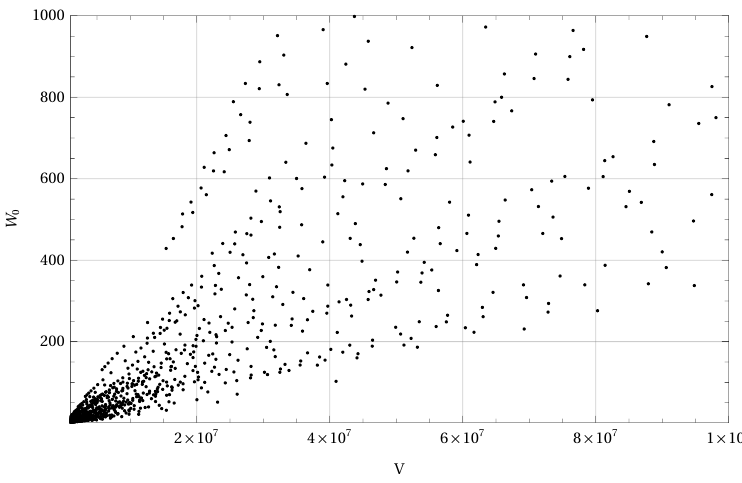
Figure 1 . Points in the ( W 0 , V ) plane which reproduce the observed amplitude of the density perturbations and DM